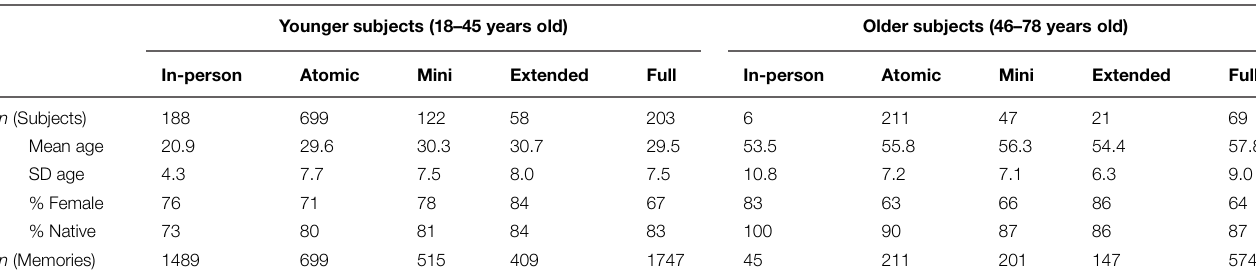
TABLE 1 | The distribution of scored autobiographical memories (AMs) collected across test types and participant